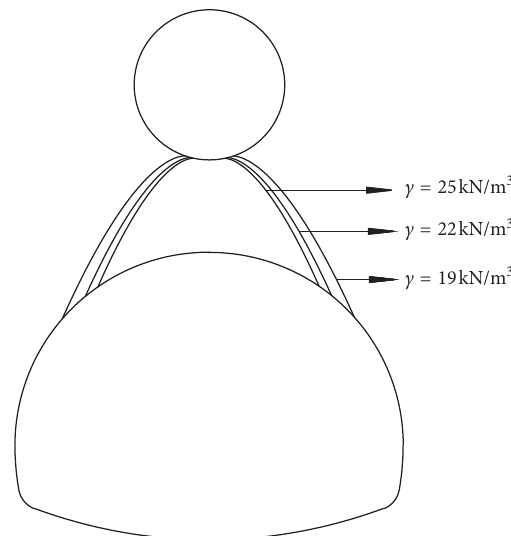
Figure 6: The shape and range of the collapse surface for different values of c